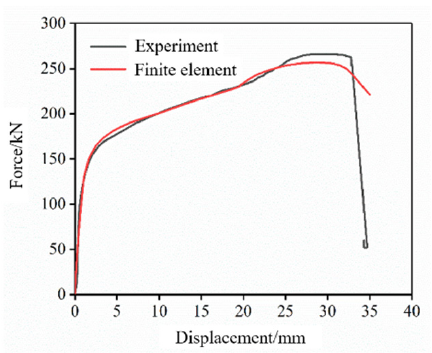
Figure 9. Load–displacement curve comparison of T1.